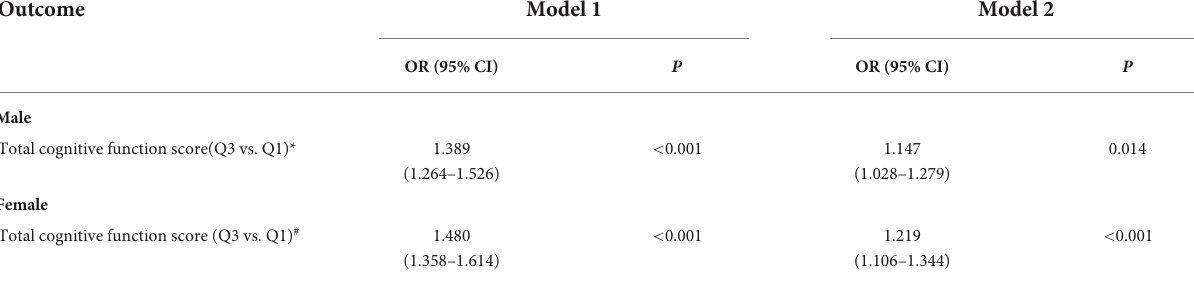
TABLE 4 Binary logistic regression models for correlations between SI and cognitive